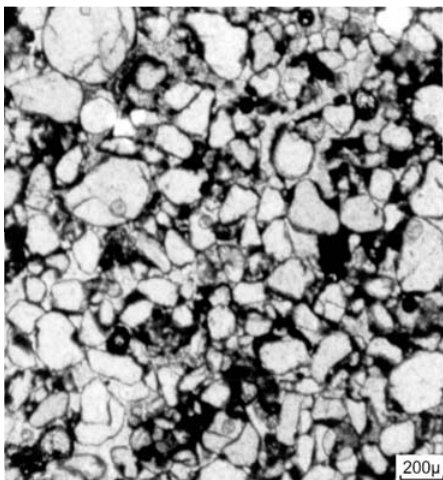
Figura 4. Imbricamento dos grãos do esqueleto nos horizontes superficiais (Ap e BA) do perfil 1.